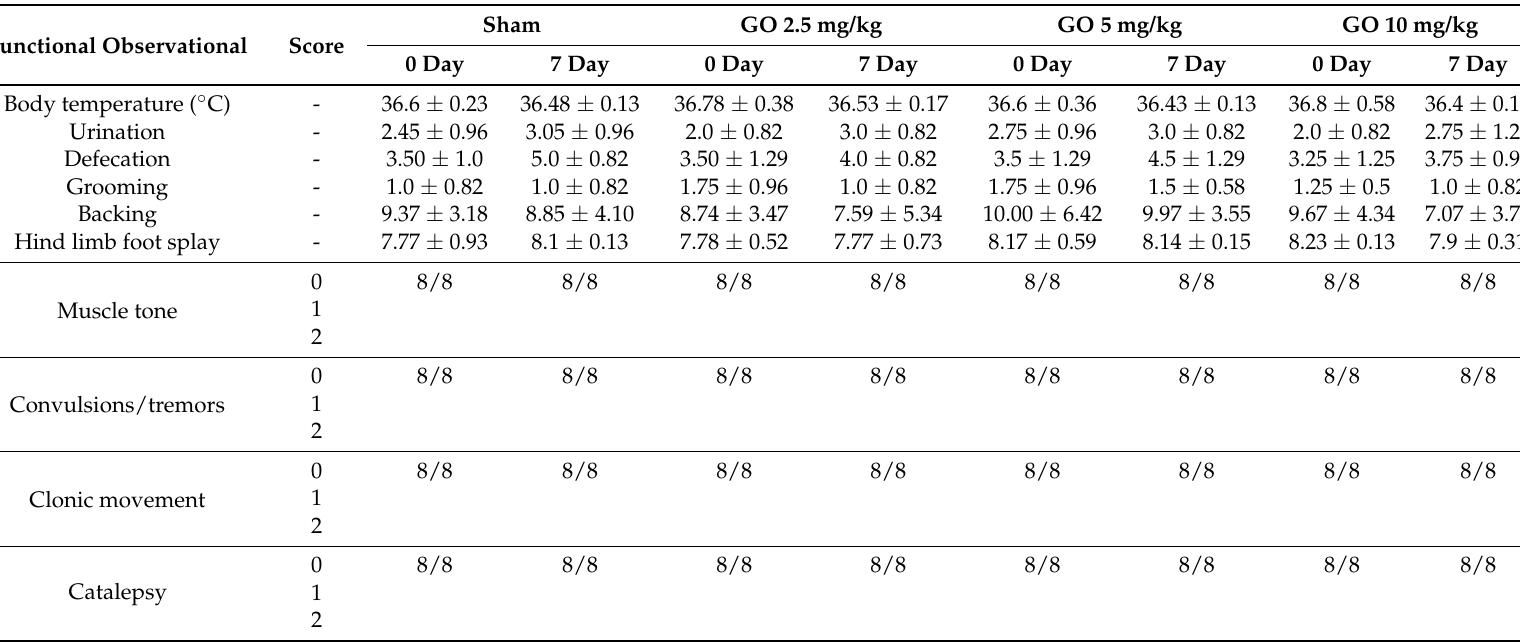
Table 3. Functional Observational Battery (FOB) of rats before or after GO